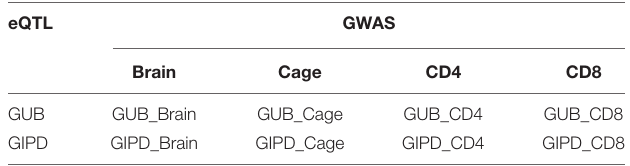
TABLE 1 | The new dataset list for SMR